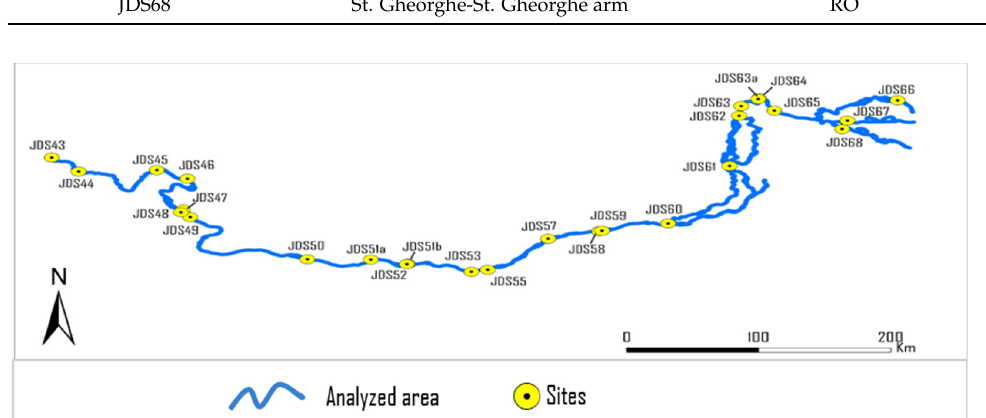
Figure 7. Romanian Danube JDS3 sampling sites (modeled on Liška et al. [54]).